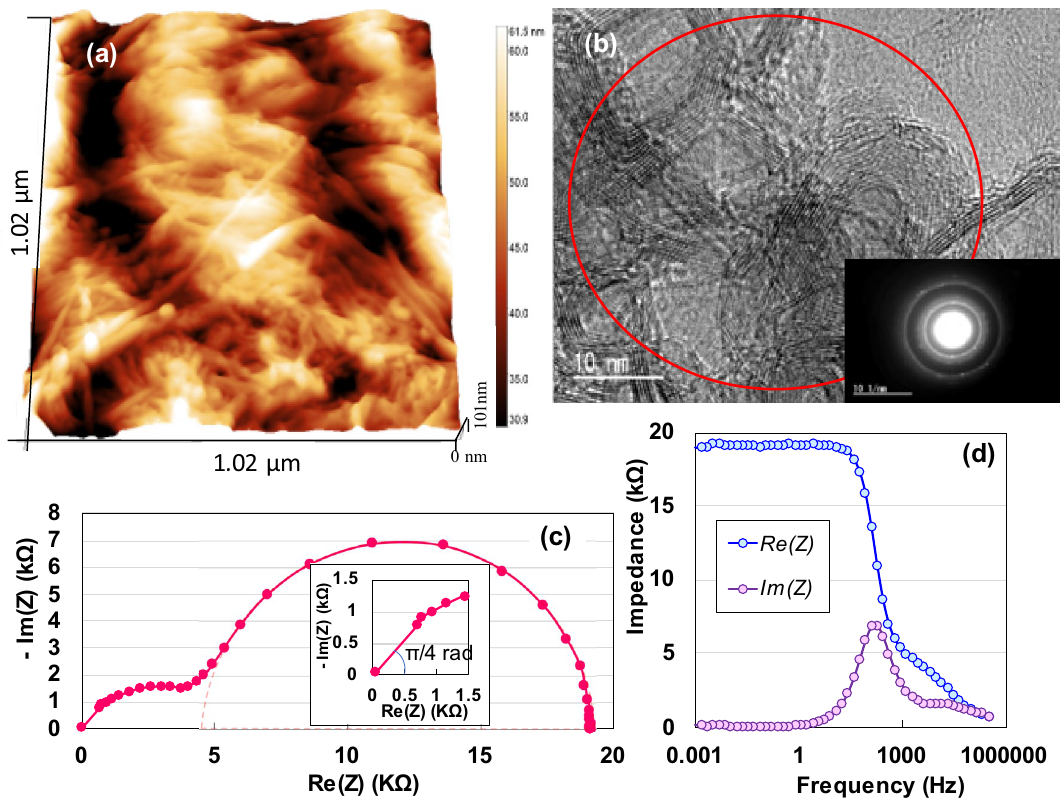
Figure 3. ( a) AFM and TEM images ( b ) of AKCF specimen and ( b) SAED pattern of red circle area (inset in ( b )); ( c ) Nyquist plot as a function of frequency for the AKCF device; ( d ) Real and imaginary